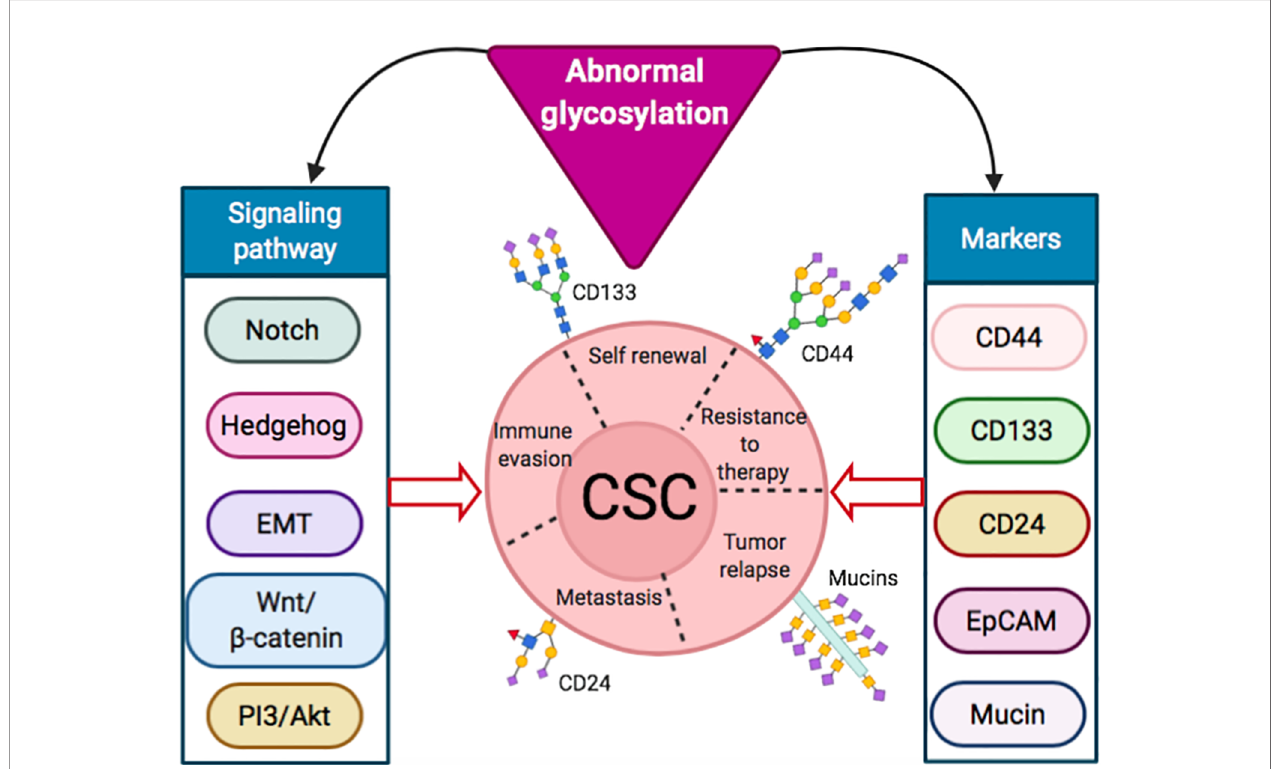
FIGURE 1 | Abnormal glycosylation in signaling pathways and markers inducing stemness properties of